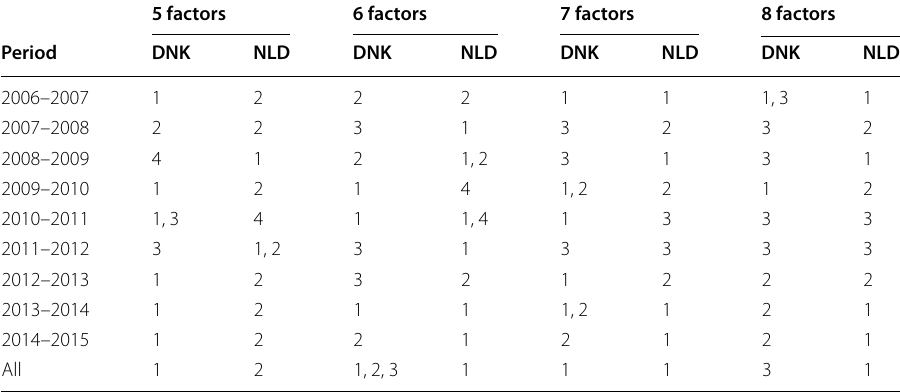
Table 4 Best-performing shortcuts to the complete additive SDA, by share of the best estimates